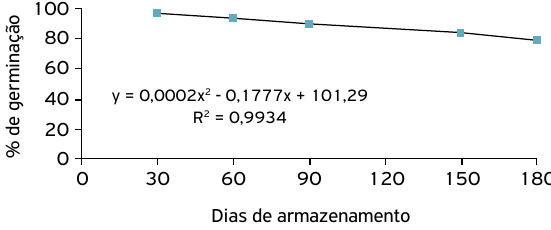
Figura 2. Porcentagem de germinação de conídios de B. bassiana em mistura granulada acondicionada em embalagem de poliéster metalizado armazenada em refrigerador (temperatura 6 ± 2°C) durante 180 dias.